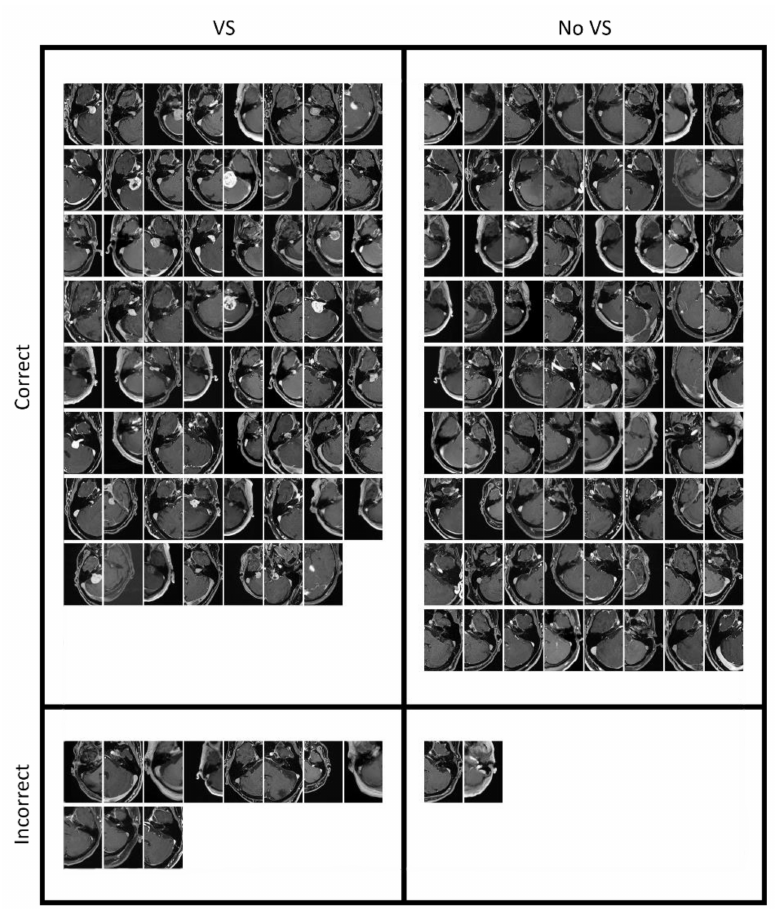
Figure 5. All MRI slices of the external validation data set with the T1c sequence. The images are sorted based on whether they contained a VS and whether they were correctly